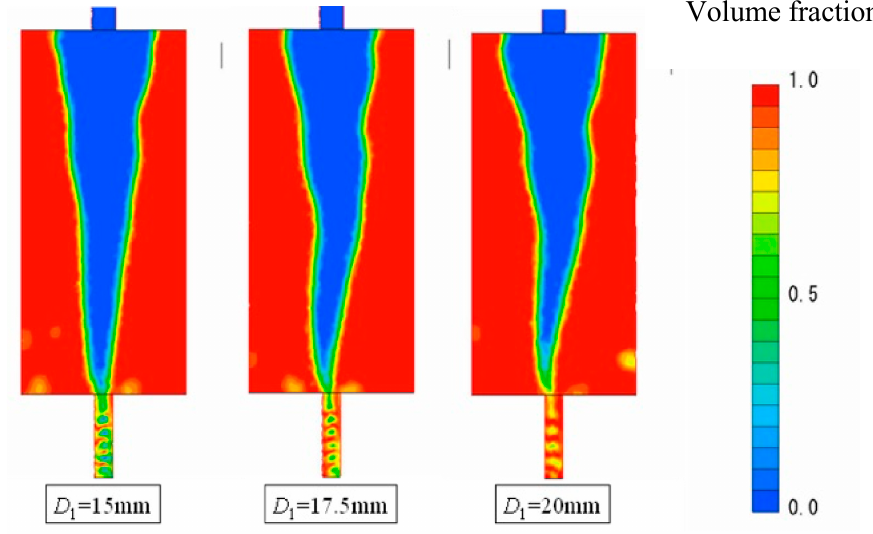
Figure 7. Volume fraction contour of the central section.